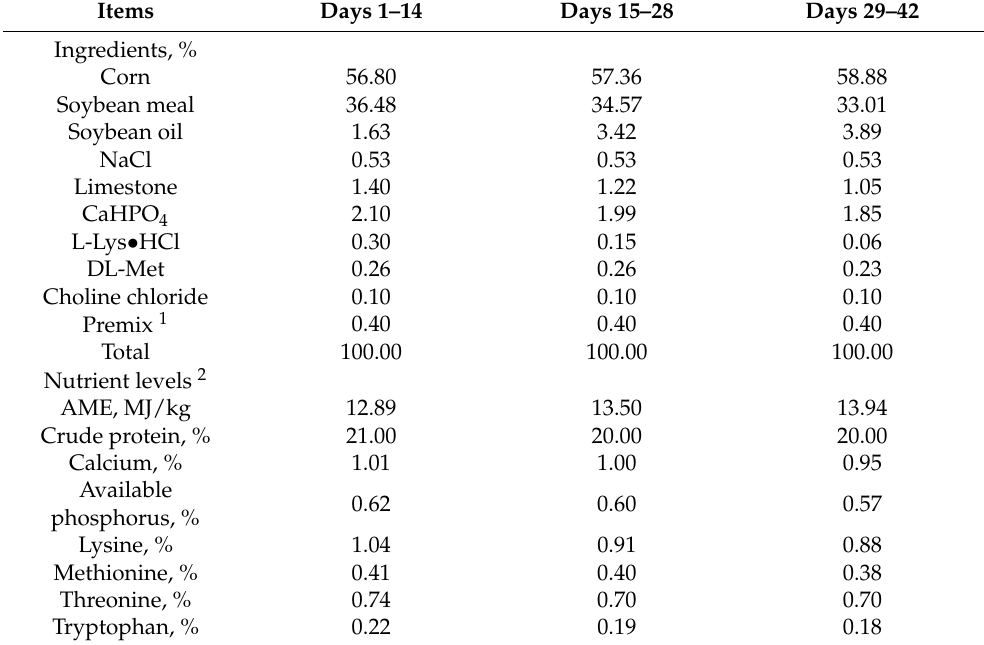
Table 1. The basic diet information